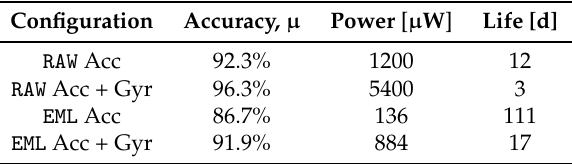
Table 11. The Trade-off between Accuracy and Lifetime.